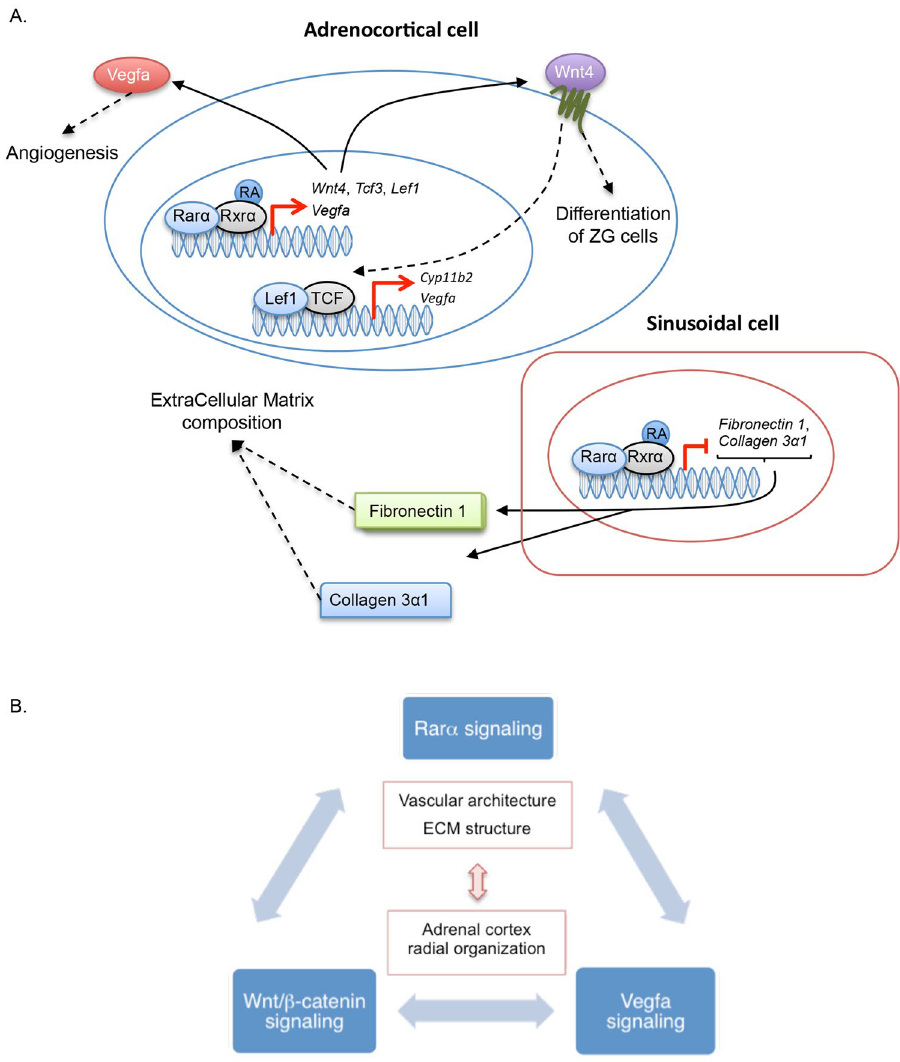
Figure 7. Proposed model for the role of Rar α in adrenocortical development. ( A ) Rar α regulates the expression of genes involved in the regulation of Wnt non-canonical pathway ( Wnt4 , Tcf3 , Lef1 … ), angiogenesis ( Vegfa ) and Extra Cellular Matrix integrity ( Fibronectin1 , Collagen 3 α 1 … ) contributing to the organization of the adrenal cortex. Wnt4 activated pathway contributes to the differentiation of ZG cells, Vegfa to normal angiogenesis and Fibronectin1 and Collagen 3 α 1 being components of the Extra Cellular Matrix. ( B ) Model in which a homeostatic equilibrium between Rar α , Wnt and Vegf signaling pathways is required for the normal development of the vasculature and Extra Cellular Matrix structure, leading to normal adrenal cortex